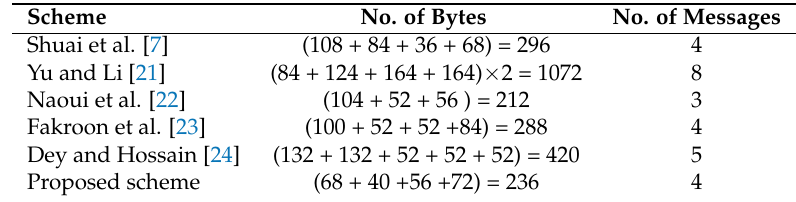
Table 1. Communication costs comparison.